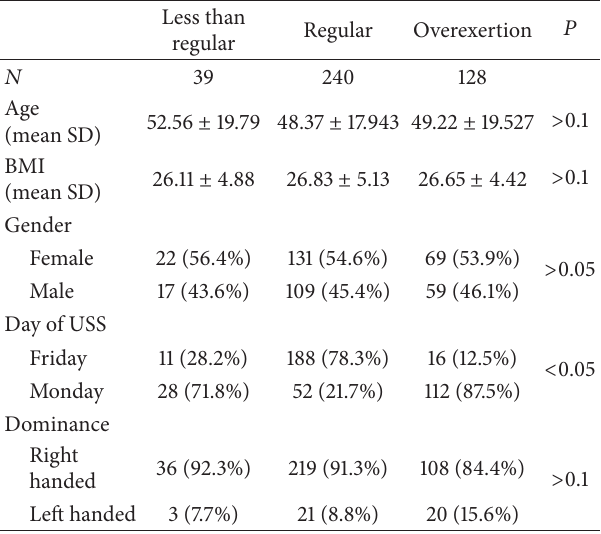
Table 1: Epidemiologic characteristics of the studied population according to self-reported level of